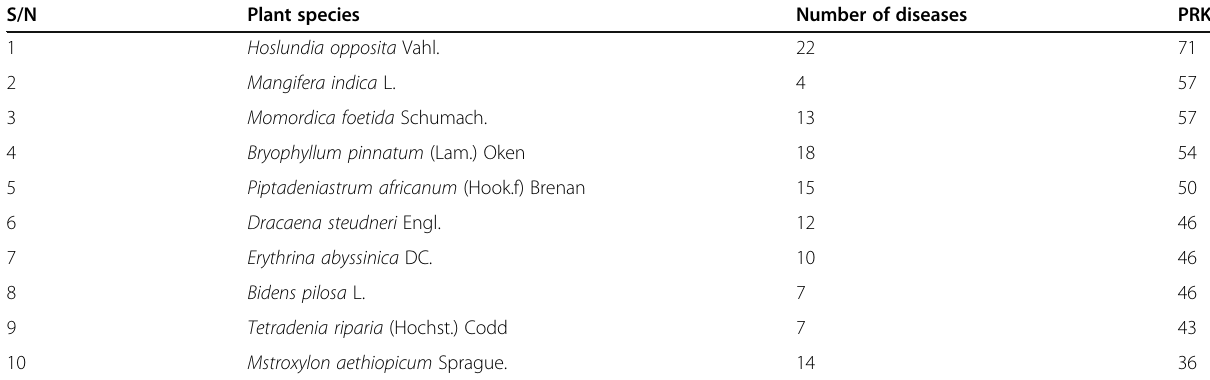
Table 2 Ten most frequently reported diseases and species with high PRK S/N